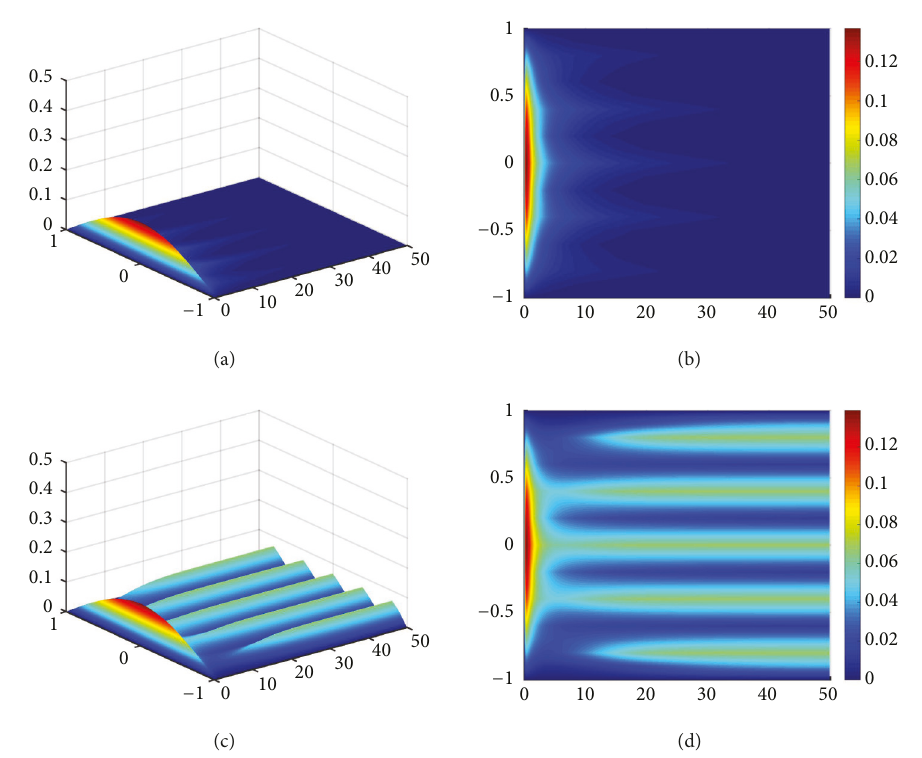
Figure 1: The evolution of the density of free viruses with parameters listed in the text. ((a) and (b)) The variation of the free virus density ̃𝛽 = 1.1 with . ((c) and (d)) The variation of the free virus density with